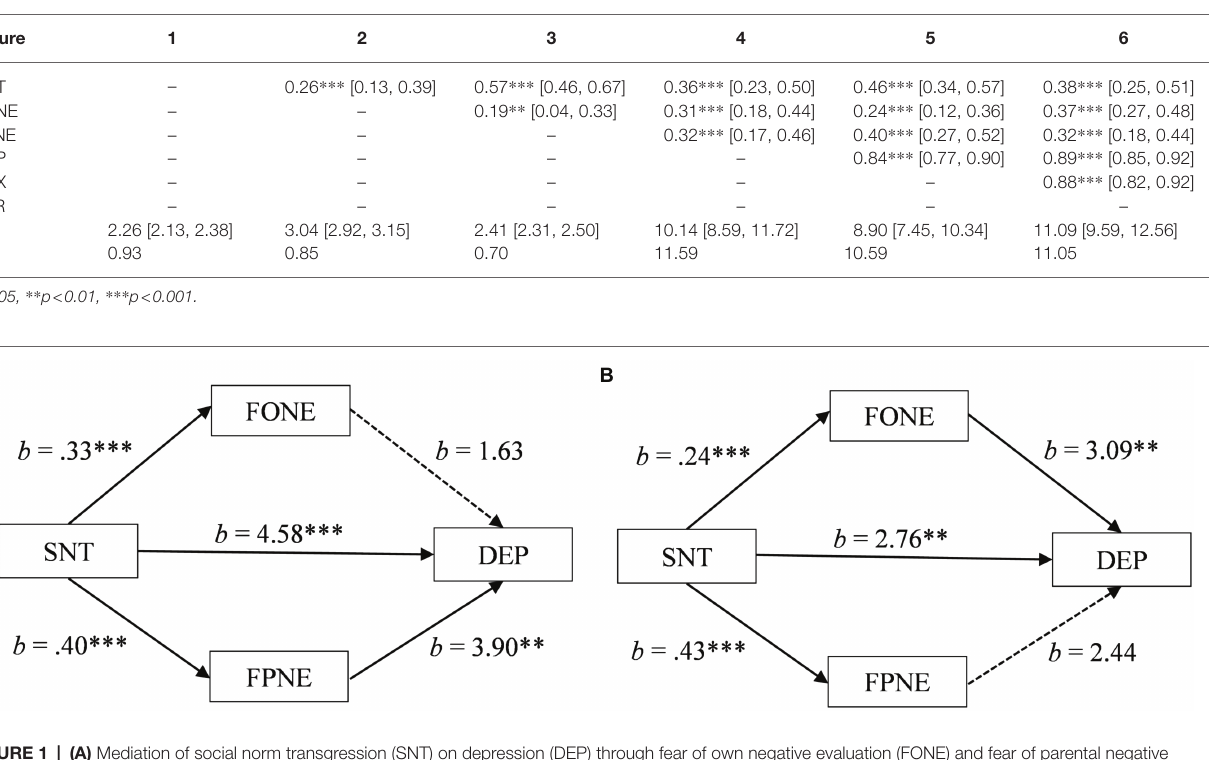
FIGURE 1 | (A) Mediation of social norm transgression (SNT) on depression (DEP) through fear of own negative evaluation (FONE) and fear of parental negative evaluation (FPNE) for South Asian participants. (B) Mediation of social norm transgression (SNT) on depression (DEP) through fear of own negative evaluation (FONE) and fear of parental negative evaluation (FPNE) for White participants. * p < 0.05, ** p < 0.01, and *** p < 0.001.